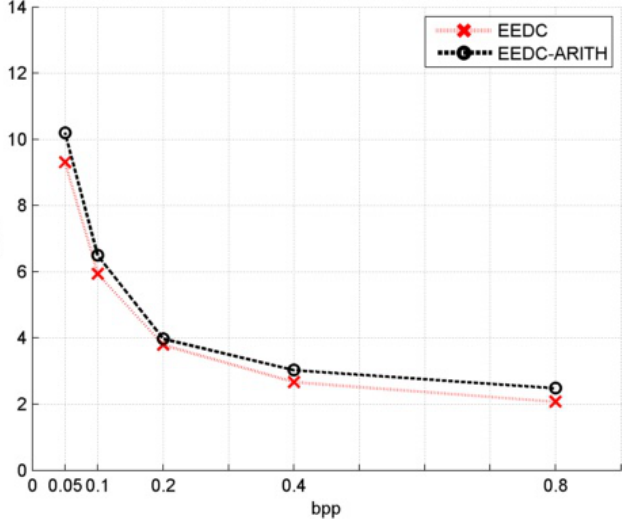
Figure 5. AAE for image horse and modified gray values compression using arithmetic